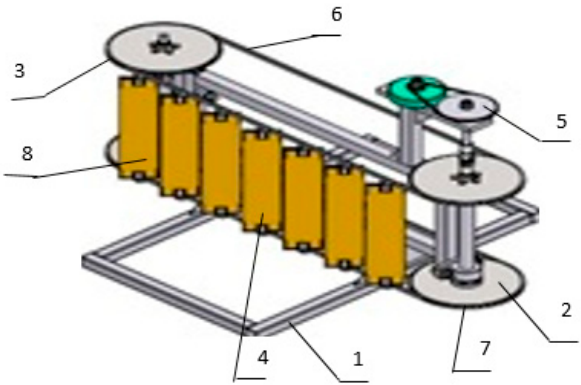
Figure 1. General scheme of the mini-hydropower plant (mini-HPP): (1) frame; (2, 3) shafts; (4) blades; (5) two-stage gearboxes; (6, 7) chain; (8) double-row lattice of the closed belt.